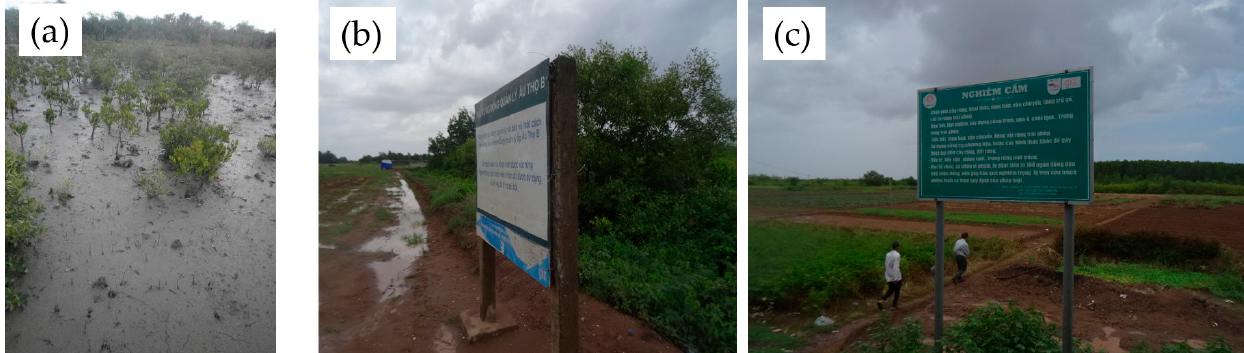
Figure 1. Reforestation zone in Sundarbans mangrove area in India (a), protected mangrove forest adjacent to rice paddies (b), and vegetable-growing field adjacent to mangrove forests (c) in Soc Trang, Vietnam.